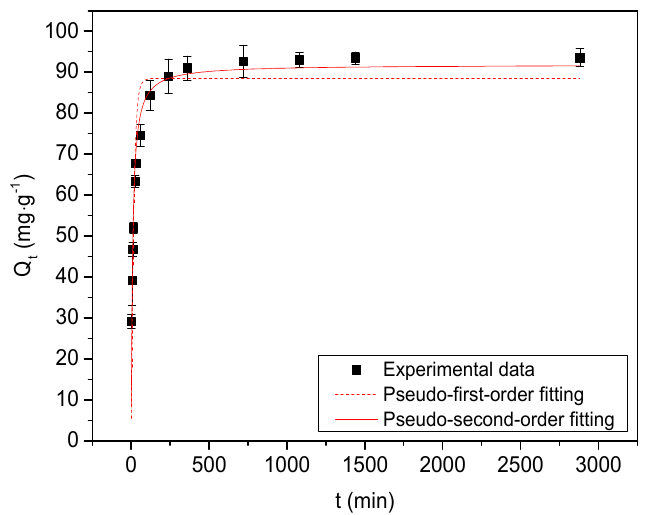
Figure 4. The influence of reaction time on the Cl − uptake on CAL-60 and nonlinear fits achieved using Pseudo-first-order model and Pseudo-second-order model (Temperature = 25 °C; CAL sample/NaCl solution = 10 g/L; initial chloride ion concentration and pH was set as 80 mmol/L and 7, respectively).